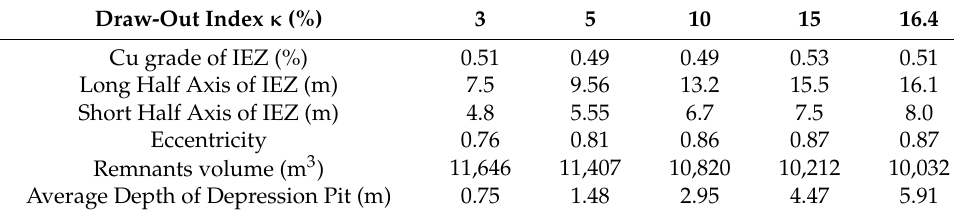
Figure 8. Simulation results of particle flow on main section under different κ values. (initial κ = 0%) ( κ = 3%) ( κ = 5%) ( κ = 10%) ( κ = 15%) (cutoff κ = 16.4%). Table 1. Result of particle flow simulation under different draw-out index values.